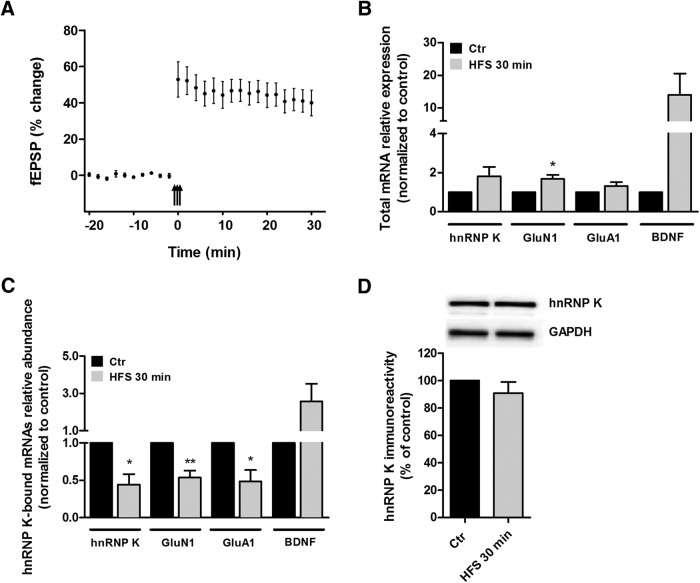
LTP-induced regulation of hnRNP K-associated mRNAs in vivo. Experiments were performed in live anesthetized rats. Electrodes were positioned for selective unilateral stimulation of the medial perforant path fibers in the angular bundle and recording of the evoked field potentials in the hilar region of the DG. A, Time course plots showing changes in the medial perforant path-evoked fEPSP slope expressed as percentage of baseline. Values are means ± SEM. Test pulses were applied at 0.033 Hz. The HFS paradigm (indicated by arrows) consisted of eight pulses of 400 Hz, repeated four times at 10-s intervals. Three sessions of HFS were given at intervals of five min. n = 6 for each time point. B, The variation of hnRNP K, GluN1, GluA1, and BDNF mRNA levels was assayed by qPCR using total RNA samples obtained from DG homogenates collected 30-min post-HFS and the nonstimulated contralateral control tissue. The results are presented as mean ± SEM normalized to the contralateral nonstimulated DG, and Hprt1 (hypoxanthine guanine phosphoribosyl transferase 1) was used as internal control gene. Results are the average ± SEM of six experiments (n = 6 DG) analyzed in three independent preparations; *p < 0.05 as determined by Student’s t test. C, The levels of hnRNP K, GluN1, GluA1, and BDNF transcripts coimmunoprecitated with hnRNP K were assayed by qPCR. hnRNP K protein was immunoprecipitated from equal amounts (500 μg) of total extracts from homogenized DG collected 30-min post-HFS and the contralateral tissue. Results are presented as mean ± SEM normalized to the contralateral DG and are the average ± SEM of six experiments (n = 6 DG) analyzed in three independent preparations; **p < 0.01; *p < 0.05 as determined by the Student’s t test. D, hnRNP K protein levels were measured by Western blotting using DG homogenate samples collected 30-min post-HFS and the contralateral nonstimulated tissue. The results are the average ± SEM of six experiments (n = 6 DG) analyzed in three independent preparations and are presented as the percentage change in hnRNP K protein levels in the treated DG relative to the nonstimulated contralateral tissue. GAPDH was used as loading control.